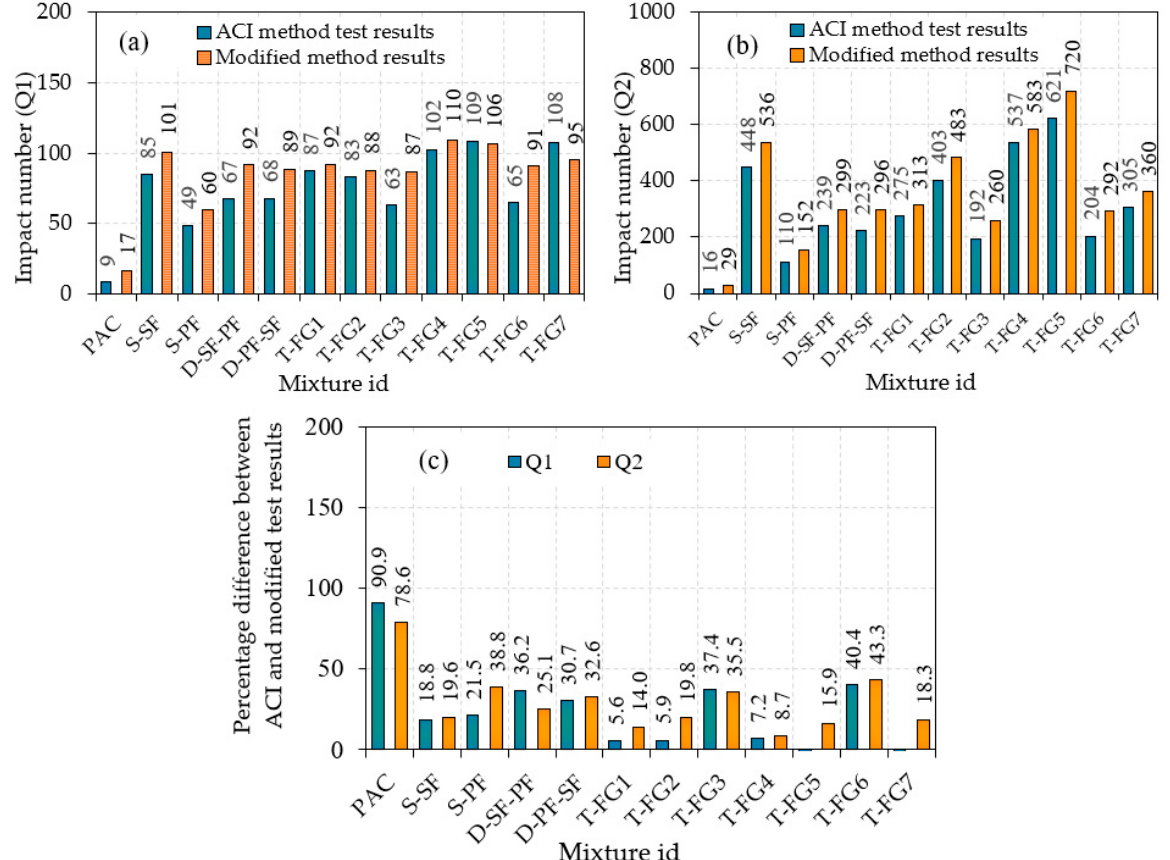
Figure 12. Impact results comparison between ACI and modified method.